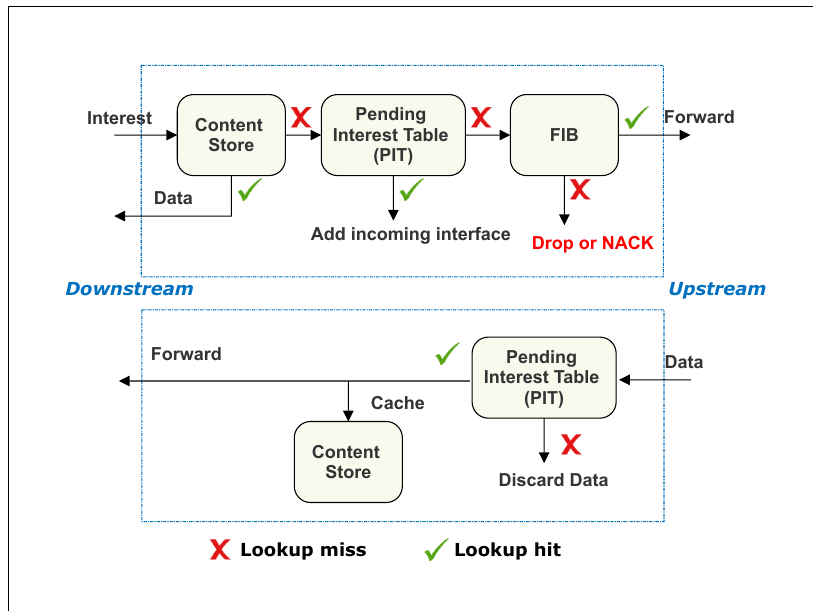
Figure 1. NDN forwarding control